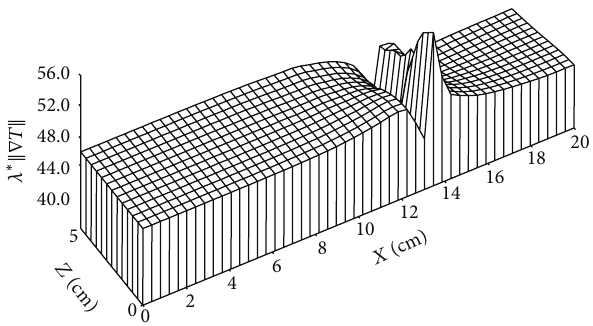
Figure 19: Distribution of heat flow due to conduction (in W/m 2 ) for 𝑡 = 135